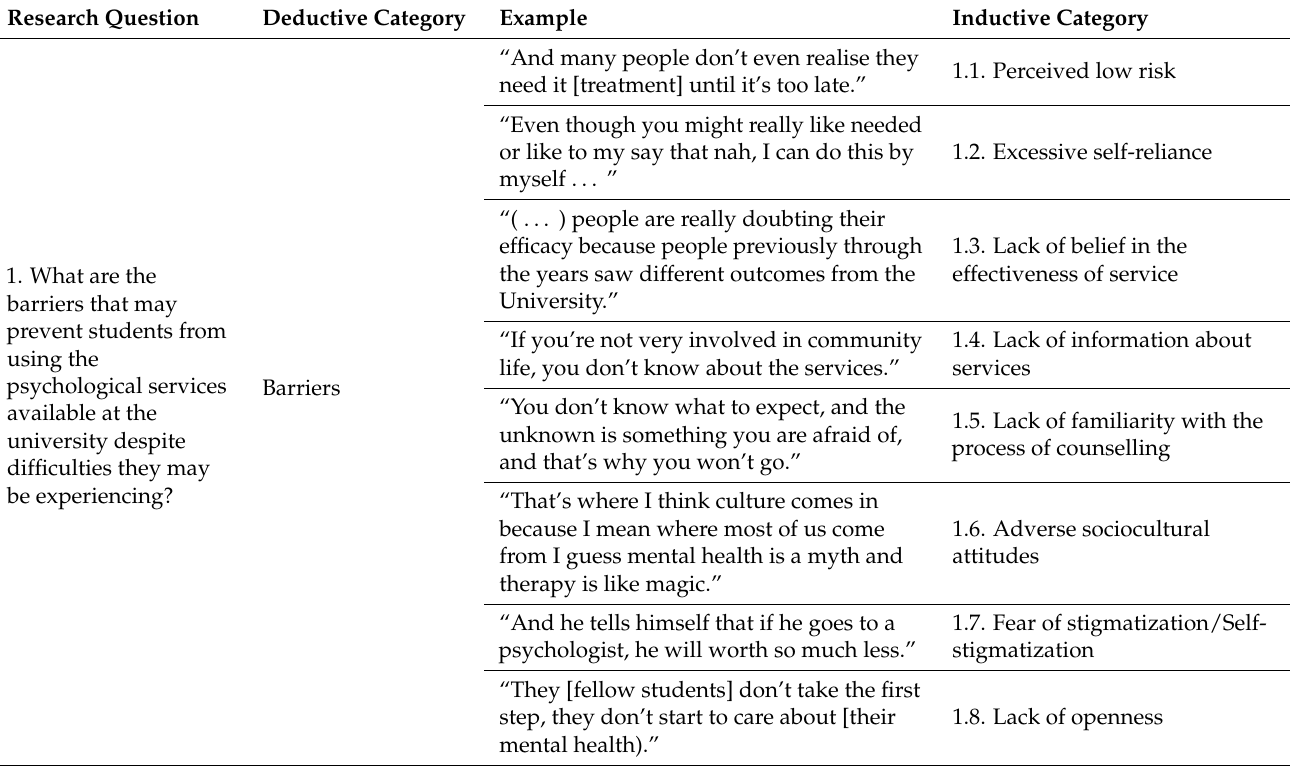
Table A1. The formation of inductive categories of barriers to seeking help and interventions to remove these